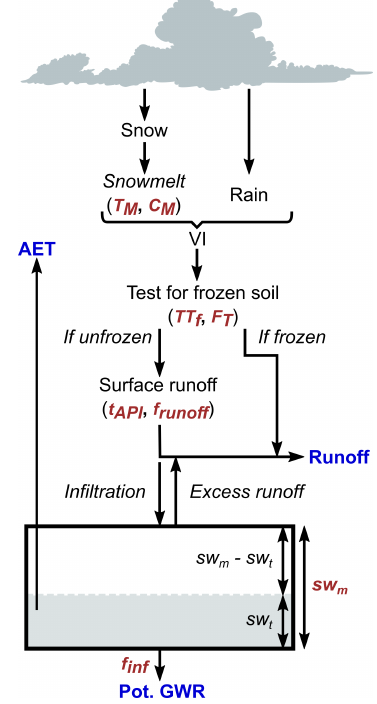
Figure 3. HydroBudget processes, including the eight calibrated pa- rameters in